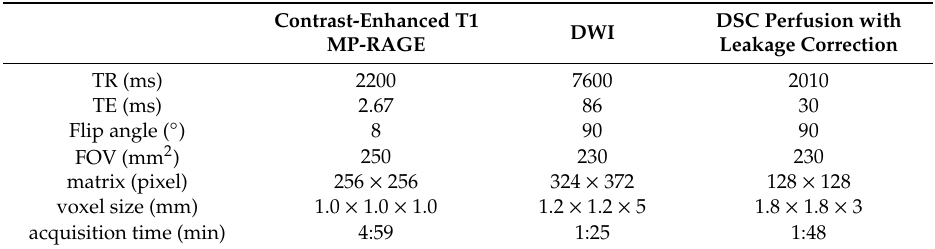
Table 1. Selected MRI sequence